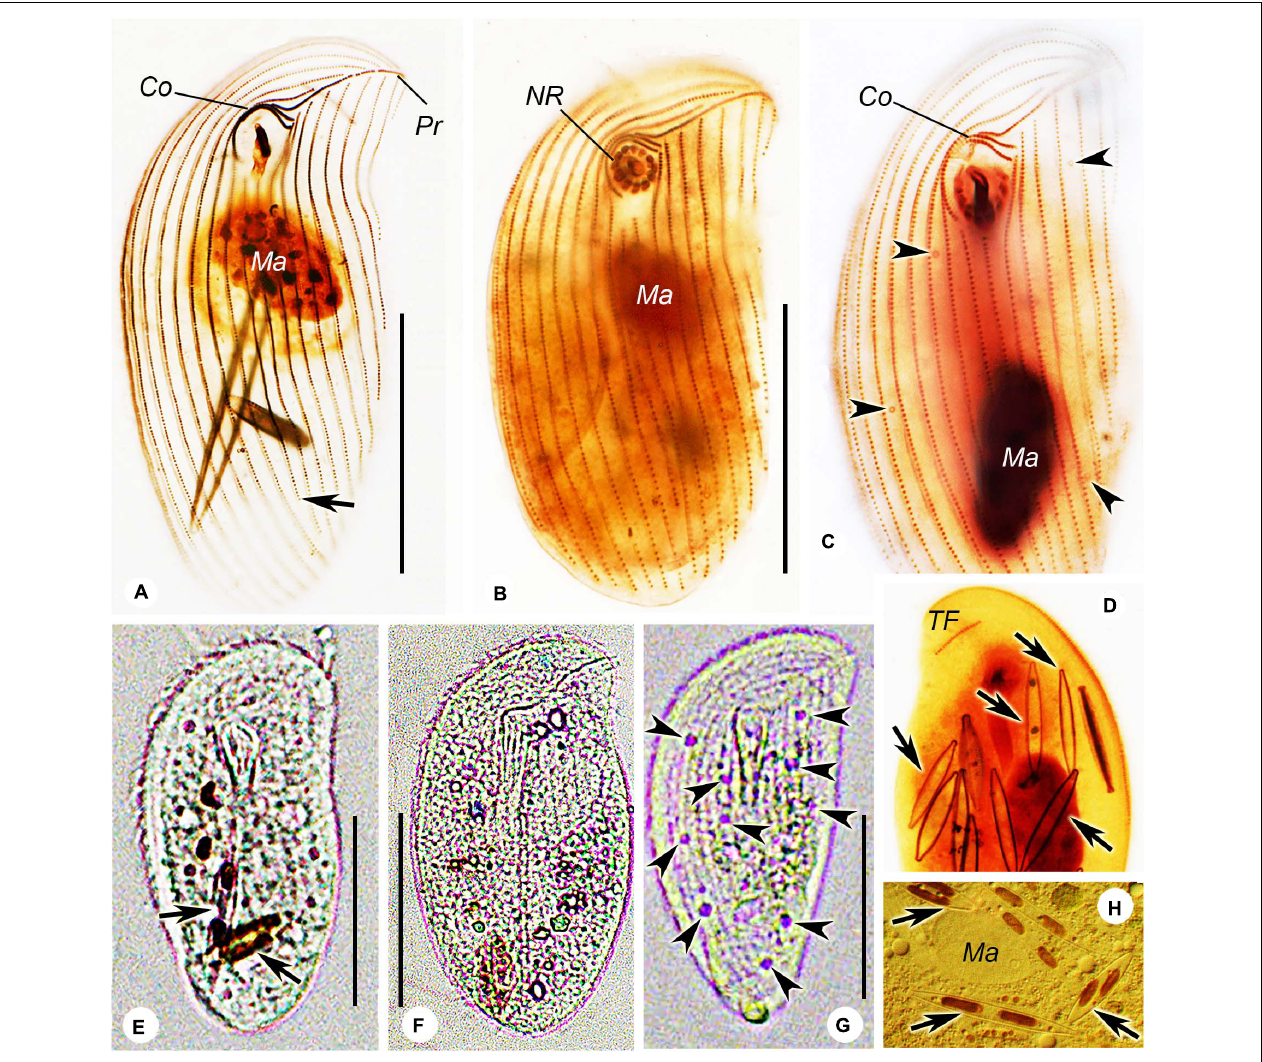
FIGURE 4 | Photomicrographs of Trithigmostoma cucullulus , Zhanjiang (A,F–H) , Shenzhen (B) , and Qingdao populations (C,D,E) . (A–C) Ventral view of protargol-stained specimens, arrowheads mark contractile vacuole pores, and arrow points to the end of the right postoral kinety. (D) Dorsal side of a stained individual, arrows denote the food diatoms. (E,F) Ventral view of cells from life. Arrows show food diatoms. (G) Ventral view of a starved cell, arrowheads show contractile vacuoles. (H) Arrow shows the food diatoms. Co, circumoral kineties; Ma, macronucleus; NR, nematodesmal rods; Pr, preoral kinety; and TF, terminal fragment. Scale bars: 40 µ